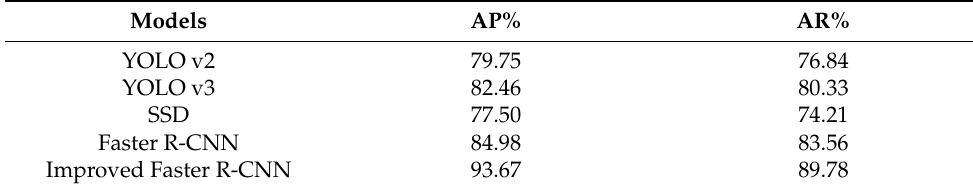
Table 3. Comparison with some SOTA models.